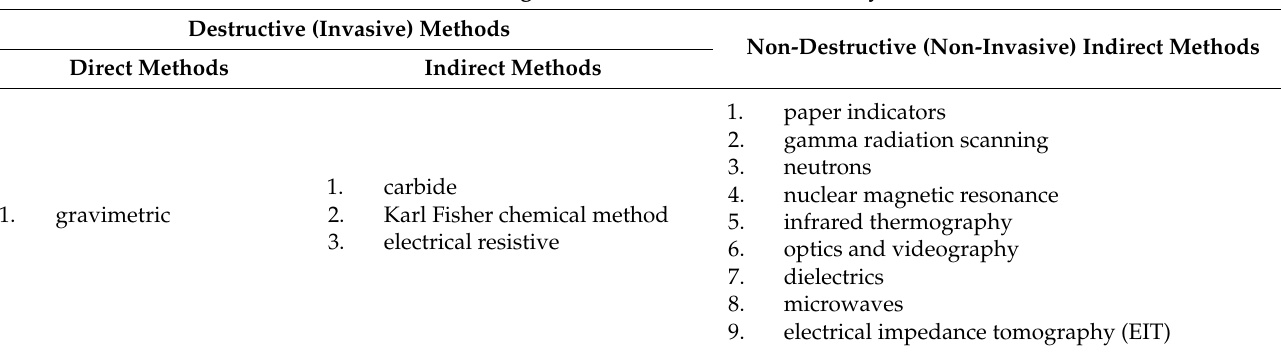
Table 1. Classification of methods for testing the moisture content in masonry walls [2,3]. Methods of Testing the Moisture Content in Masonry Walls Destructive (Invasive)